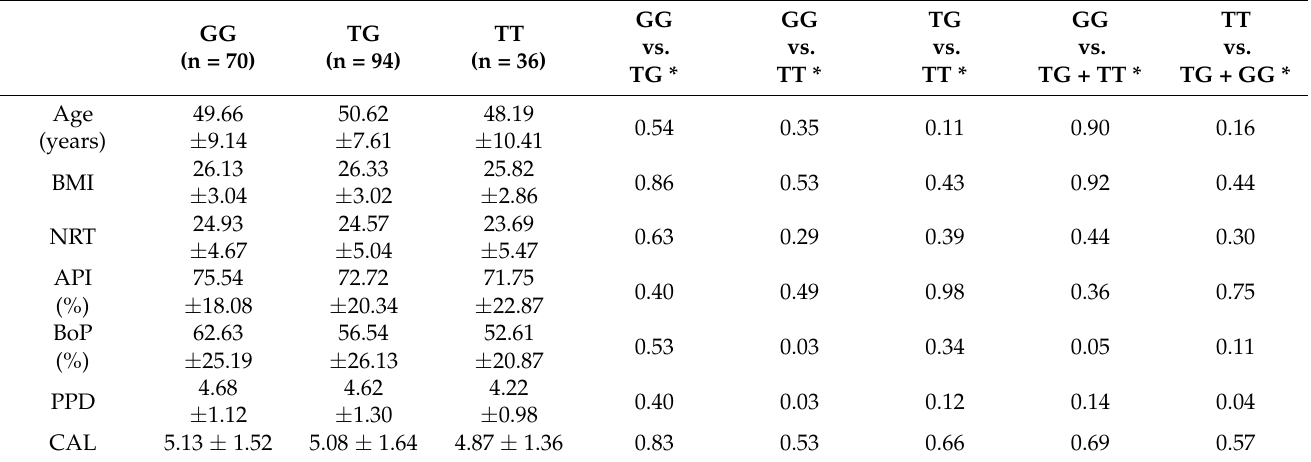
Table 6. The associations between the selected baseline clinical parameters (mean values ± SD) and IL-18 rs1946518 genotypes.